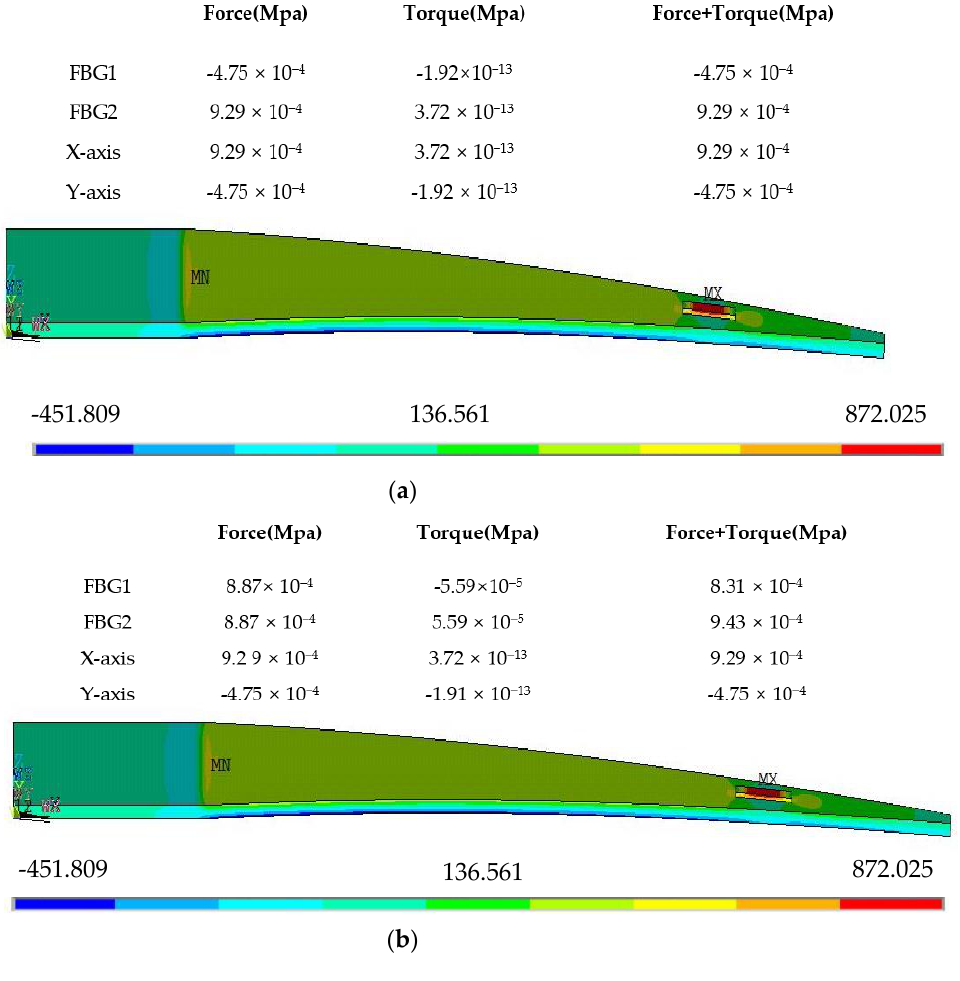
Figure 8. Simulation of equivalent stress on the 4-coordinate line at different values of α , ( a ) α 1 = 90 ◦ α 2 = 0 ◦ , ( b ) α 1 = α 2 = 10 ◦ .